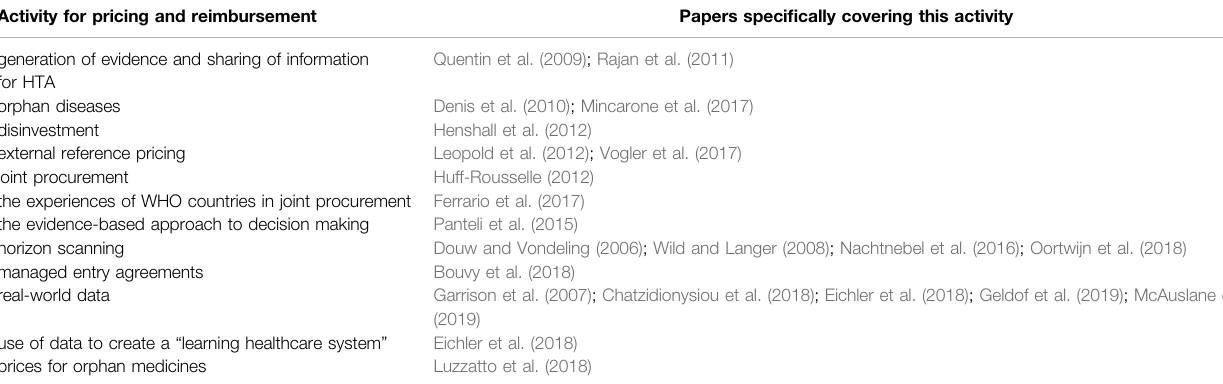
TABLE 6 | Activities of pricing and reimbursement covered in the published